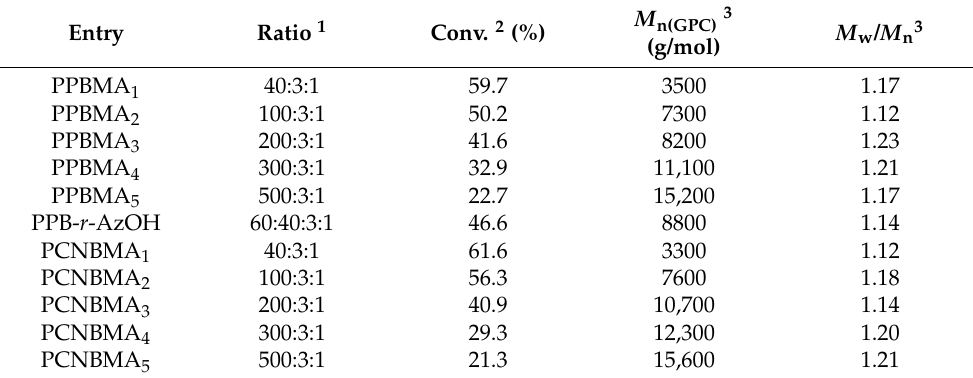
Table 1. Molecular weight characteristics of liquid crystalline